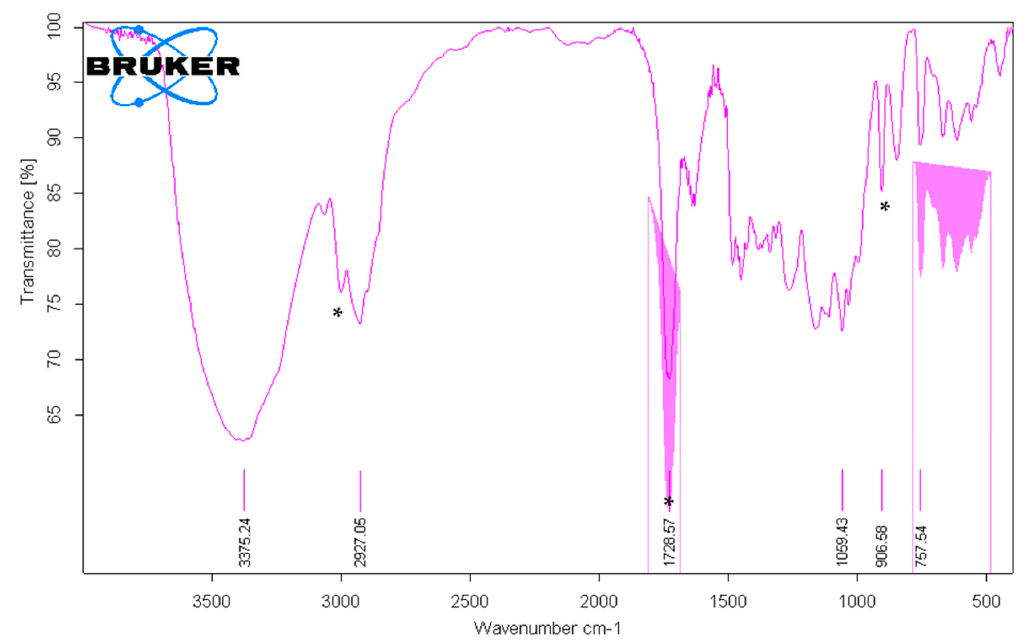
Figure 4. BNC-GMA MS = 0.8 FT–IR spectrum: cellulose profile plus GMA appendages (*).